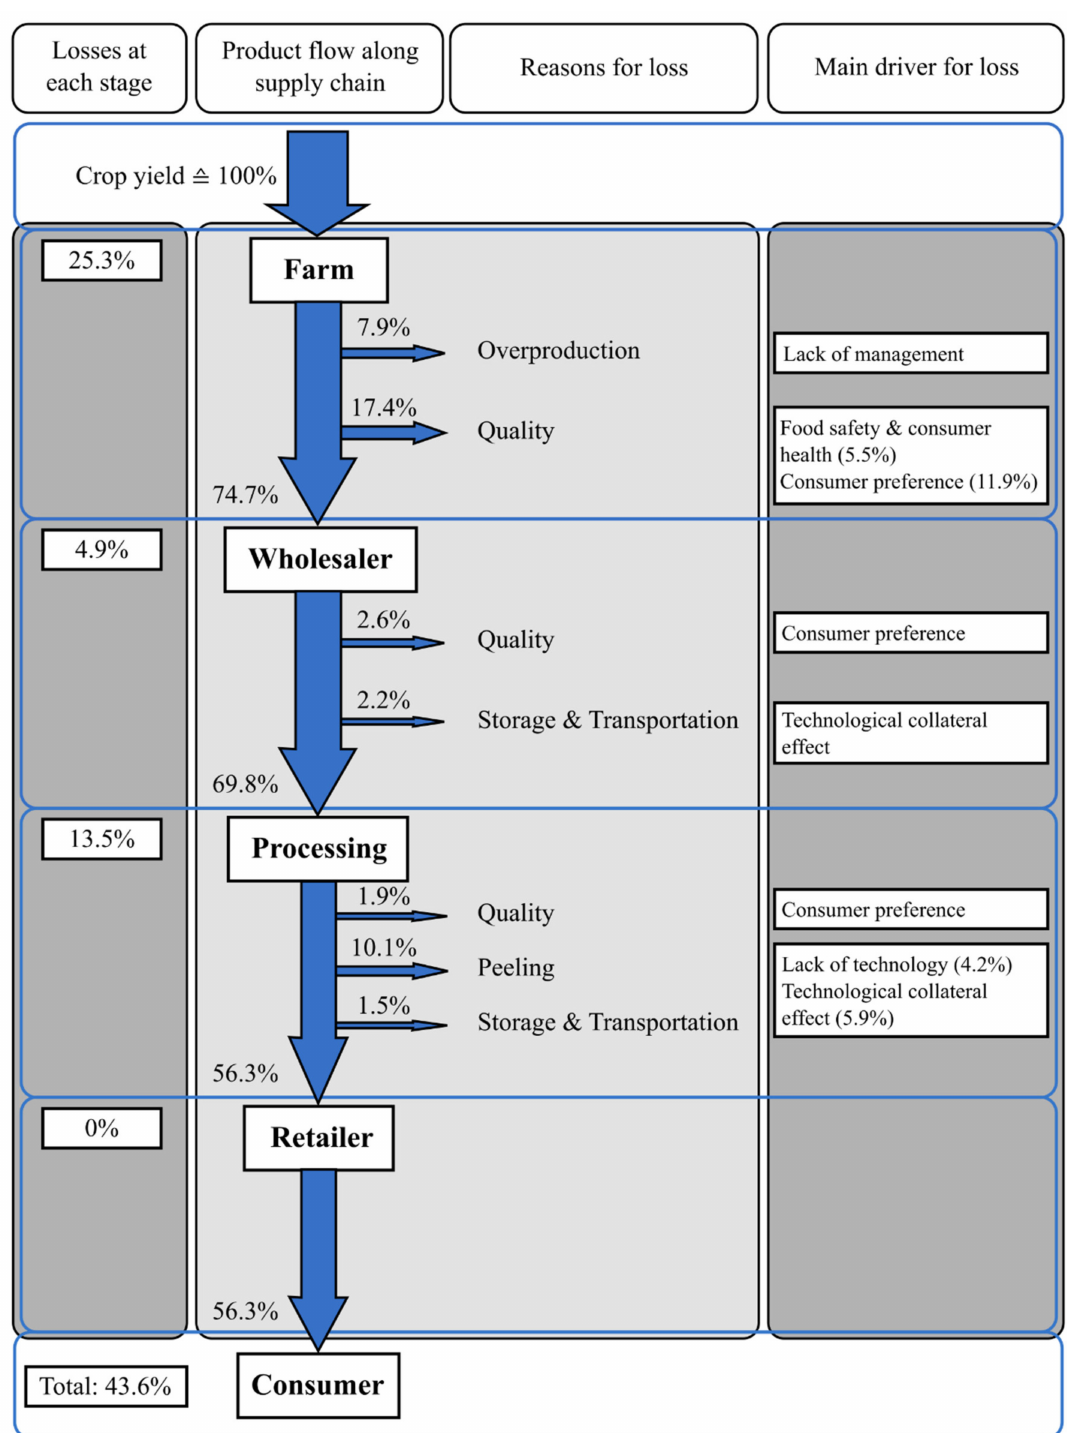
Figure 1. Mean food loss rates of non-organic processing potatoes in Switzerland at each stage of the total agricultural potato production, total supply chain losses and cause of losses. All percentages are related to an initial crop yield of 100%. ↓ Thickness of arrows represent percentage of total product flow. Cause of loss “quality” refers to potatoes, which did not suffice according to the standard quality specifications of the “Swiss trade customs for potatoes”. Cause of driver “Food safety & consumer health” refers to green and rotten potatoes, and “Consumer preference” refers to “Consumer preferences for certain aesthetic standards or typologies of food” (own illustration based on data published by Willersinn et al.